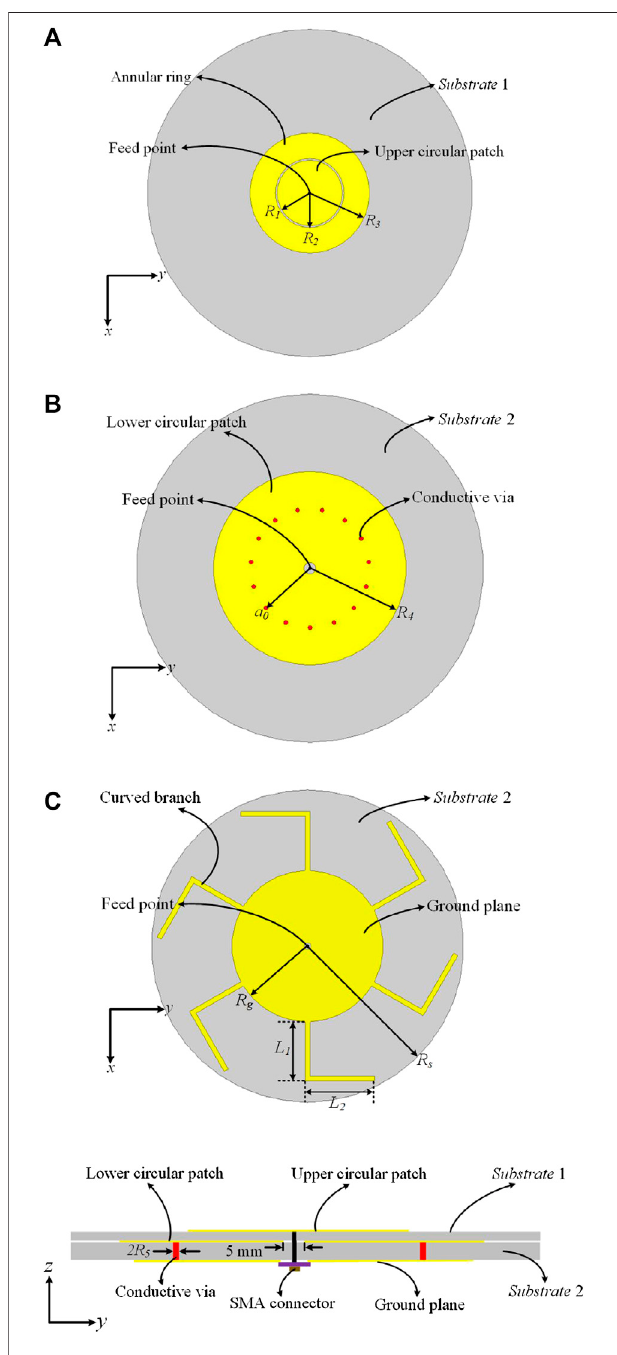
FIGURE 1 | Geometry of the proposed dual-band dual-polarized omnidirectional antenna: (A) Top view of Substrate 1; (B) Top view of Substrate 2; (C) Bottom view of Substrate 2; (D) Side view.